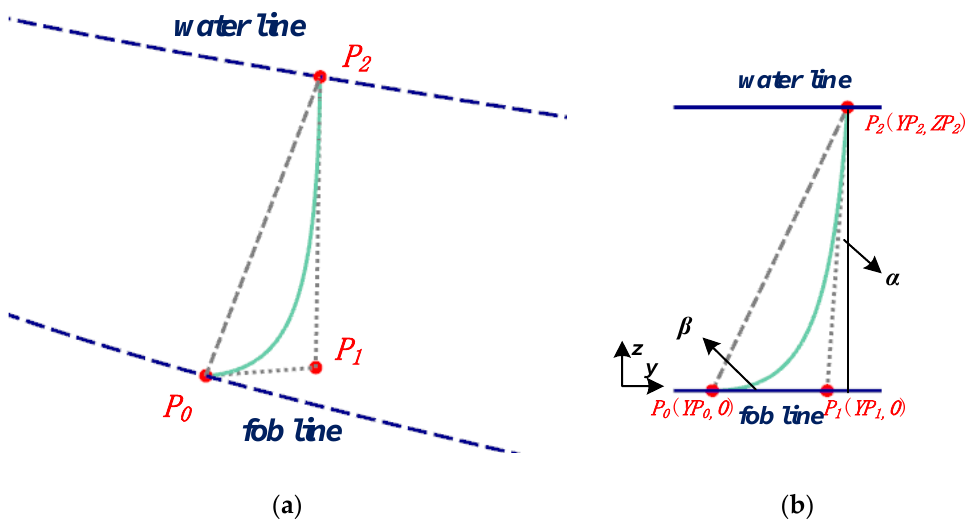
Figure 10. Schematic diagram of middle curve. ( a ): spatial position relationship; ( b ): shape of curve on the X-plane.